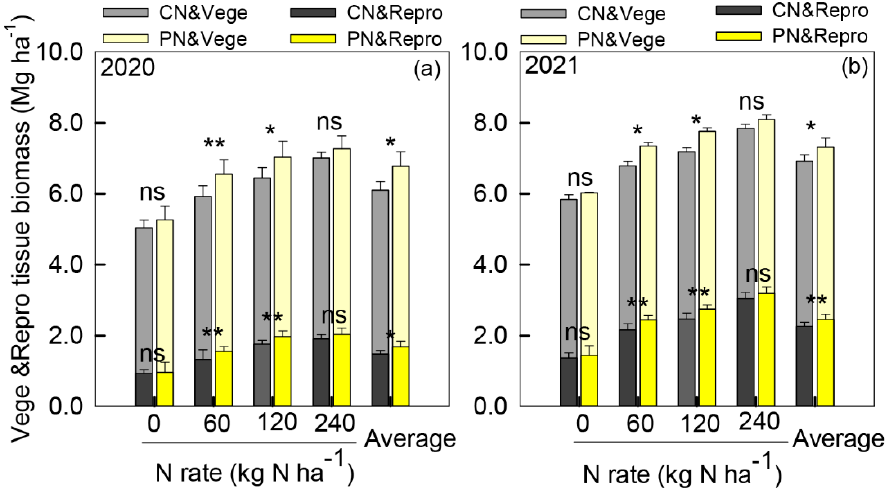
Table 1. Sorghum agronomic traits during the 5-leaf-flowering and flowering-physiological ma- turity growing stages at four nitrogen fertilizer rates under control treatment (CN) and polyaspartic acid-coated urea (PN) in 2020 and 2021.